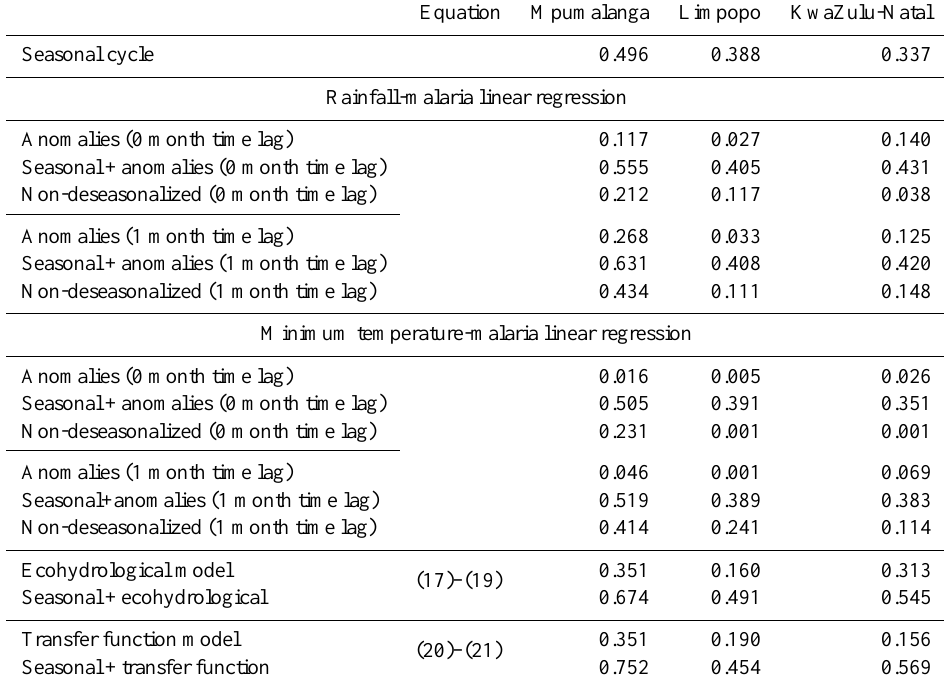
Table 1. Nash efficiencies for the seasonal component of malaria dynamics, the preliminary analysis, the ecohydrological model, and the transfer function model for the three South African provinces of Mpumalanga, Limpopo and KwaZulu-Natal. In the preliminary analysis, we examined the direct link between monthly data of malaria and rainfall, as well as malaria and minimum temperature applying linear regressions to the data before the removal of the seasonality denoted by “Non-deseasonalized” in the table and after the deseasonalization, considering only the “Anomalies” and taking into account the seasonal dynamics as well